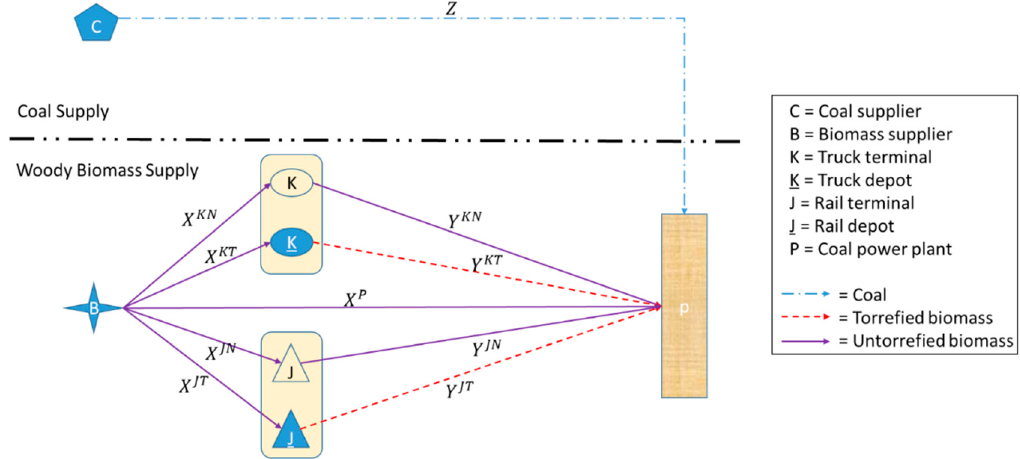
Figure 2. Combined feedstock supply chain for co-firing power plant.